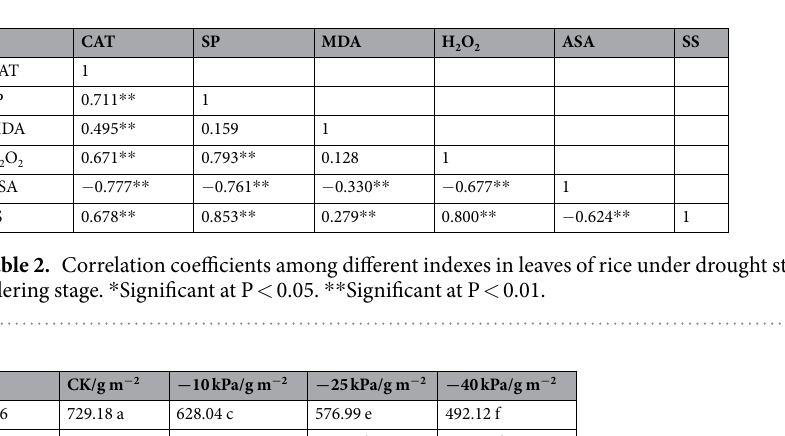
Table 1. Main effect test for CAT activity and content of soluble protein (SP), MDA, H 2 O 2 , ASA and soluble sugar (SS) in leaves of rice between treatments and varieties (F values). * Significant at P < 0.05. ** Significant at P < 0.01.